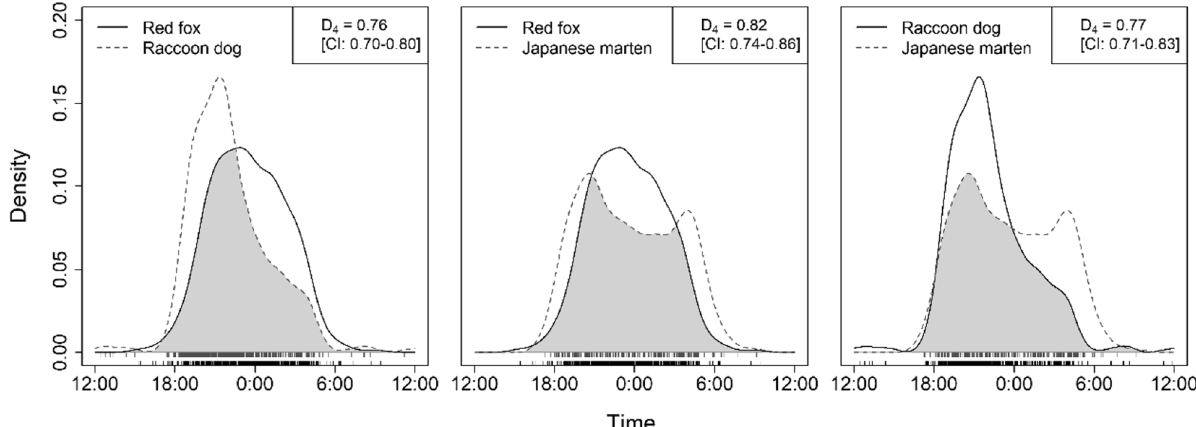
Figure 3. Temporal overlap between species. The gray area indicates the overlap between diel activity patterns. The rug at the bottom of the plot indicates the original observations of activity time. The number of samples used for the kernel density estimation was 669 for red foxes, 691 for raccoon dogs, and 282 for Japanese